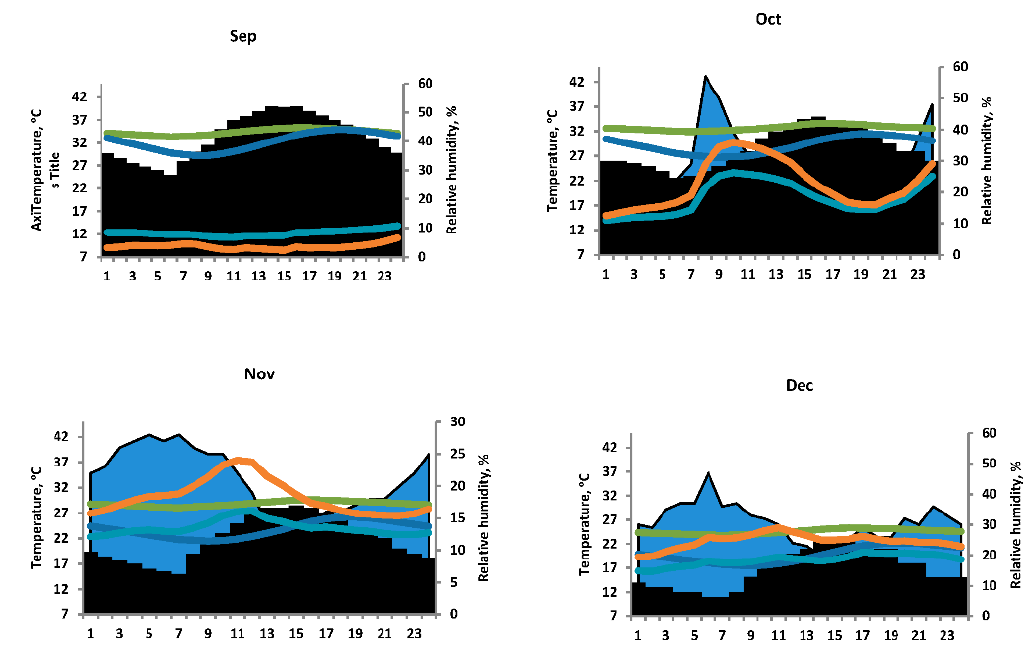
Figure 11. Indoor temperature and relative humidity of the underground room and above ground room simulated using TAS EDSL for the whole year where, ORH is outdoor relative humidity, OAT is outdoor air temperature, UGR.IAT is underground air temperature, NR.IAT is above ground air temperature, UGR.RH is underground relative humidity and NR.RH is above ground relative humidity .